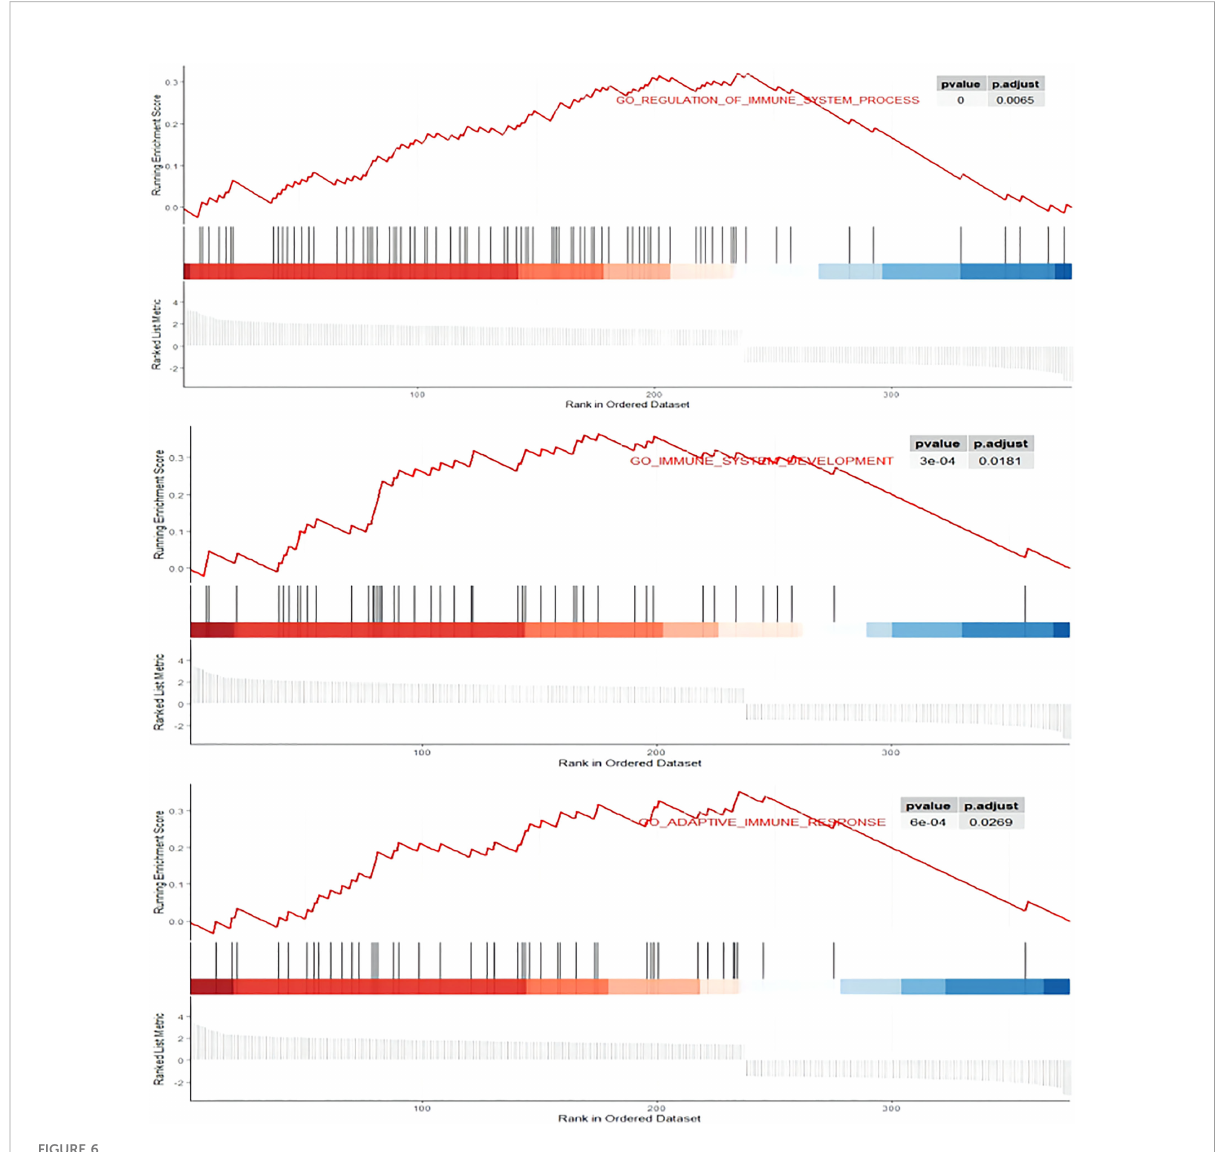
FIGURE 6 GSEA enrichment plots. DEGs was signi fi cantly correlated with the regulation of immune system process, adaptive immunity, and immune system development.